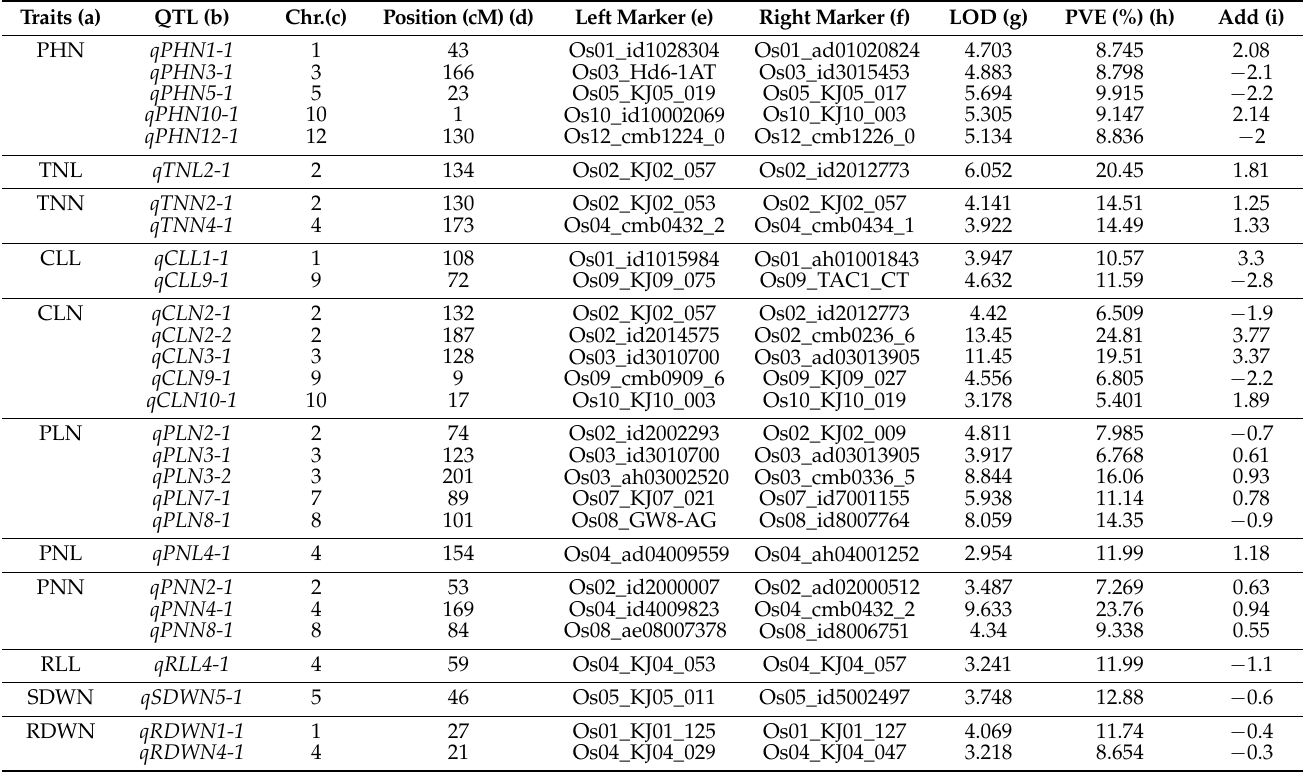
Table 2. Detected QTLs associated with growth and development, and yield components of rice under normal and low